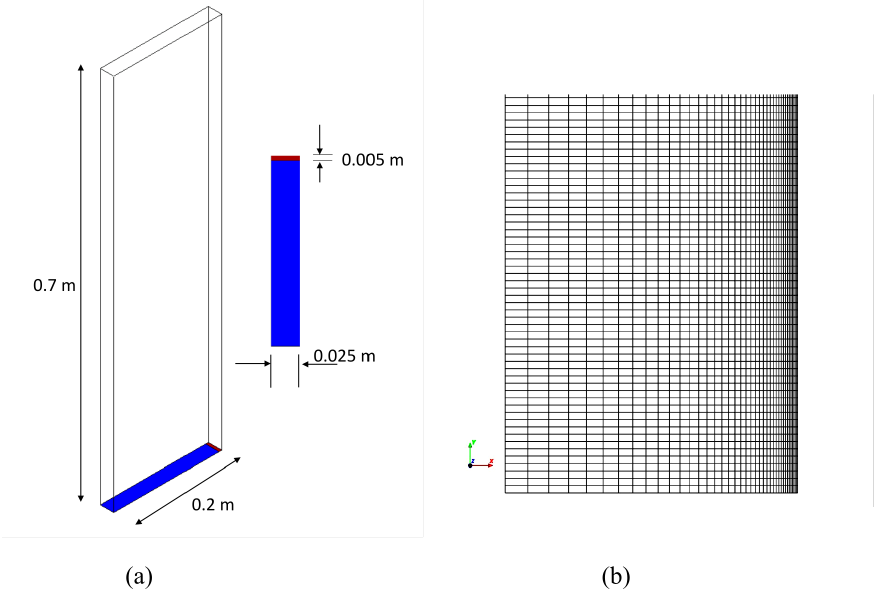
Figure 3. Scheme of the computational domain for Test 2: ( a ) Fluidized bed size and ( b ) grid